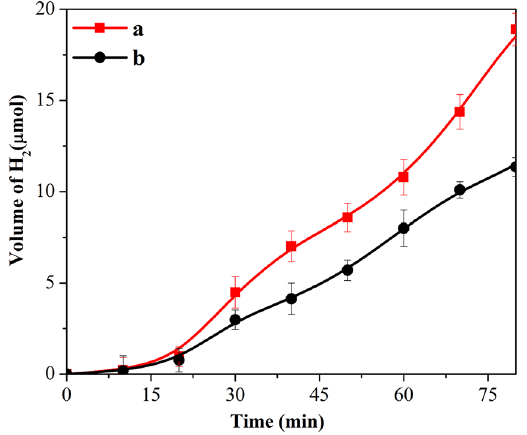
Figure 9. Photocatalytic hydrogen production over ( a ) anatase, and ( b ) rutile TiO 2 .